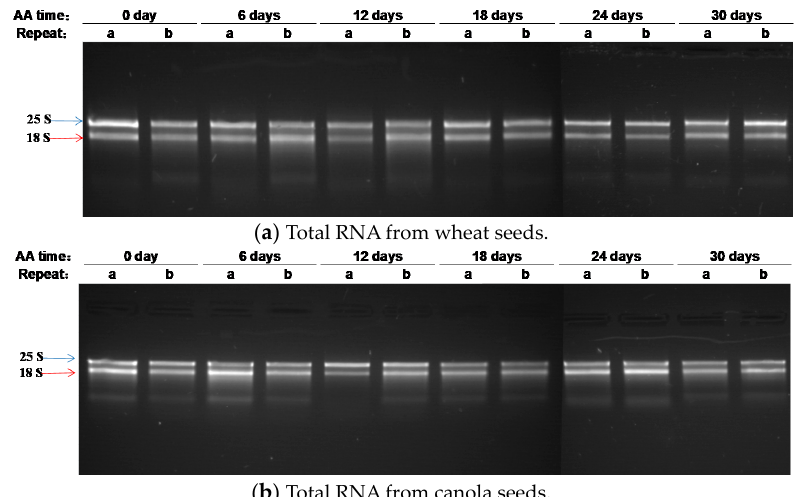
Note: Total RNAs were isolated from unaged and variously aged seeds of wheat and canola as described in the Materials and Methods. The AA day and seed germination percentage were indicated for each seed sample. Two biological replicates of RNA extraction were made for each seed sample, labeled as “a” and “b”. For each RNA sample, the RNA yield and purity (A 260 / 280 and A 260 / 230 ) were assessed using a NanoDrop 8000 spectrophotometer.